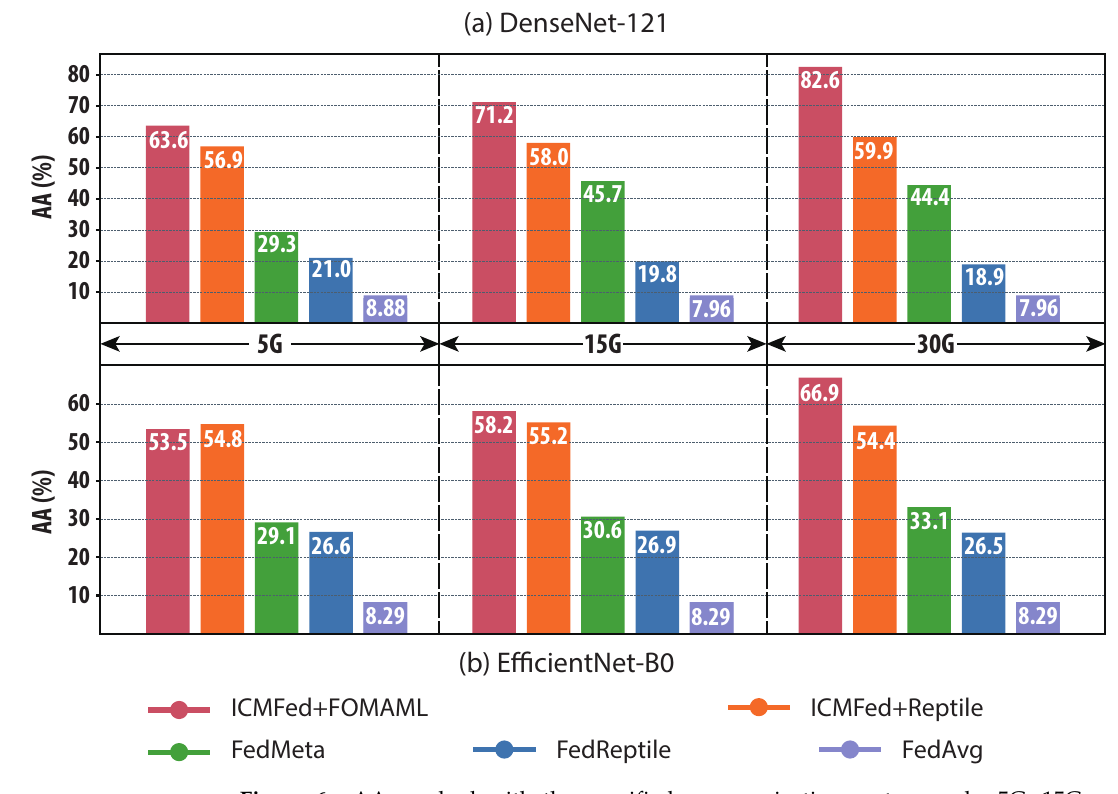
Figure 6. AA reached with the specified communication cost, namely, 5G, 15G, and 30G, in ( a ) DenseNet-121 and ( b )